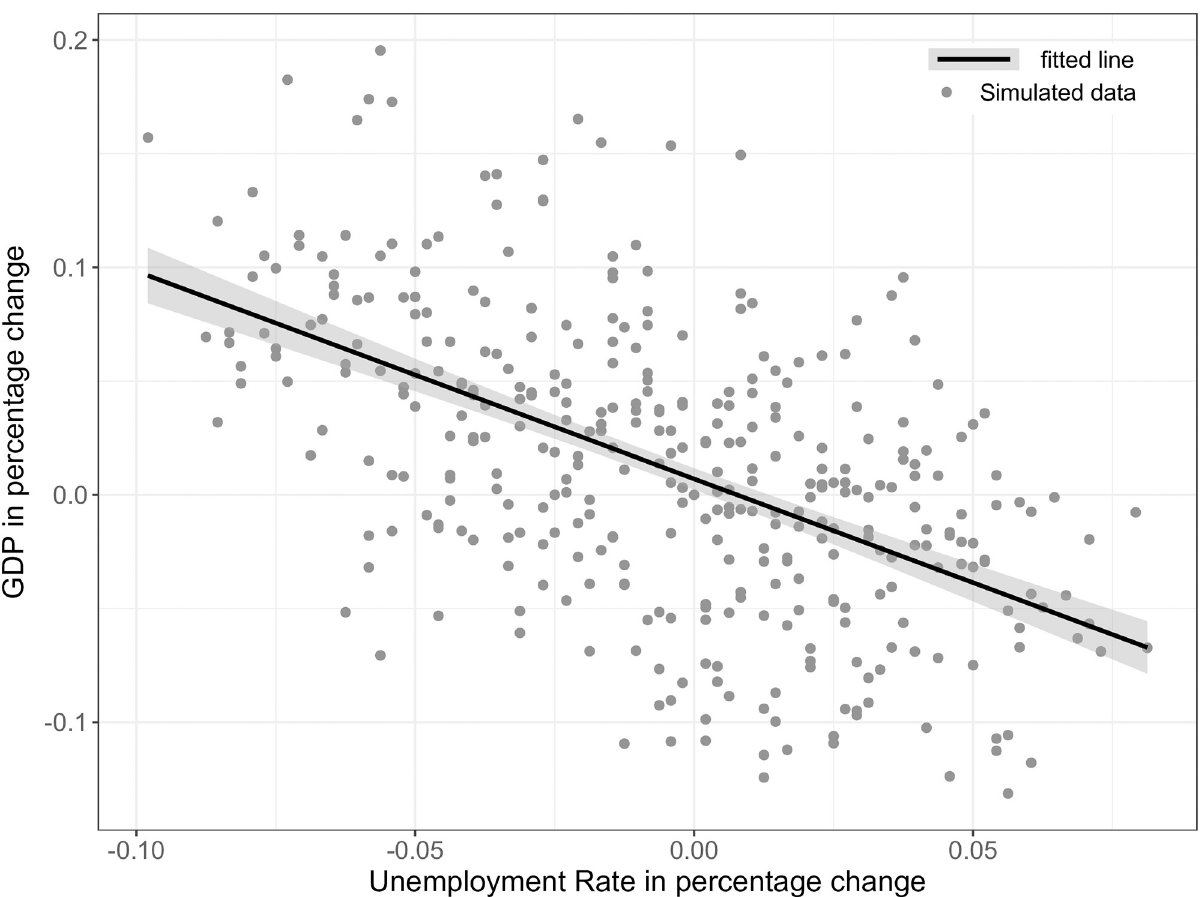
Fig 13. SF12: GDP growth in relation to unemployment growth. Note: The Figure shows a scatter plot of aggregated real GDP and unemployment percentage change with following regression features: Unemployment rate (0.007 − 0.913 x + � ); R 2 = 0.295. The natural unemployment rate is assumed to be 0.05%. The simulation output comprises 20 representative runs to increase the sample with a total number of 12,000 period observations without the warm-up phase of 200 simulation periods. The grey shaded area represents the 90% confidence interval.